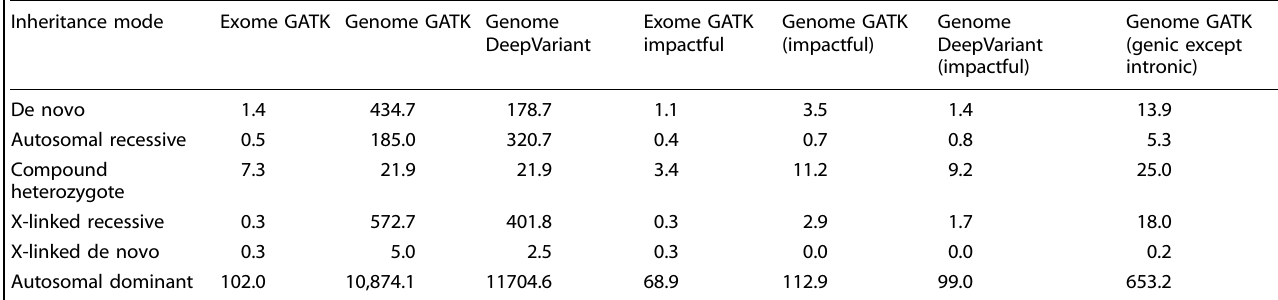
Table 2. Mean number of candidate variants for each inheritance mode for a cohort of 149 whole-exome trios and and a cohort of 94 whole- genome trios. Inheritance